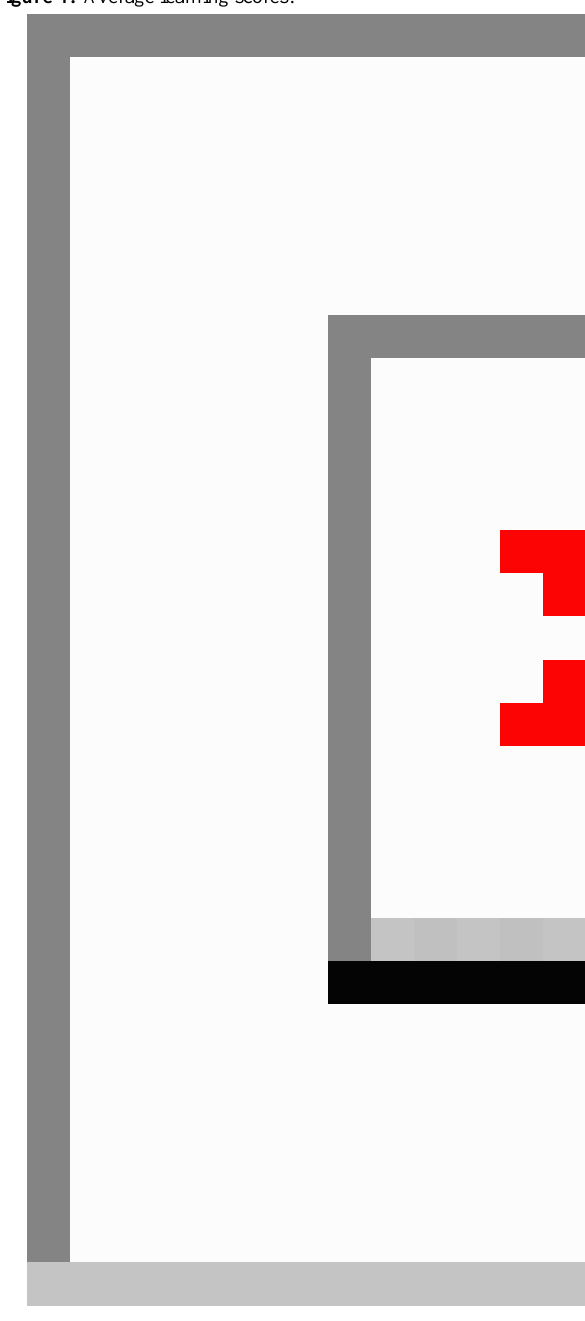
Figure 4. Average learning scores.